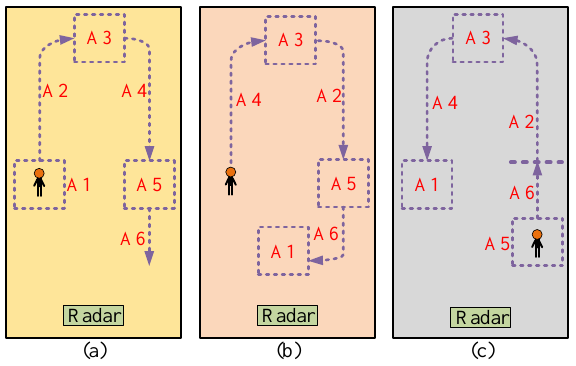
Figure 3. Trajectory of three groups of motion sequences, ( a – c ) correspond to S1, S2, and S3.